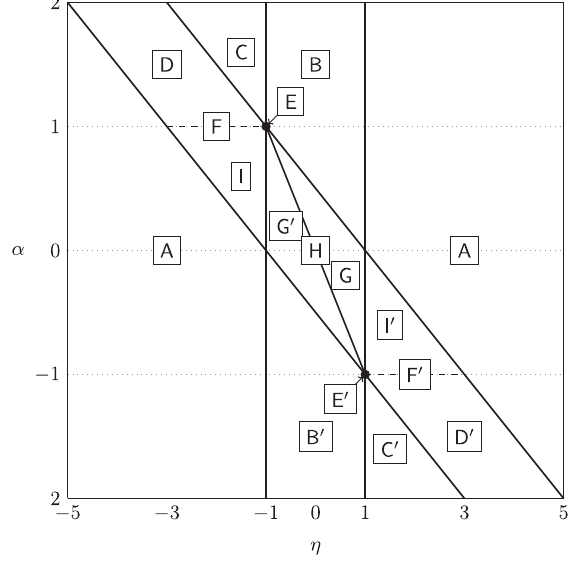
FIG. 1. Diagram of the possible phase-space topologies as a function of η and α . The letters refer to the portraits shown in Fig. 3, and the prime indicates a rotation by π = 2 with respect to the configuration shown in Fig.